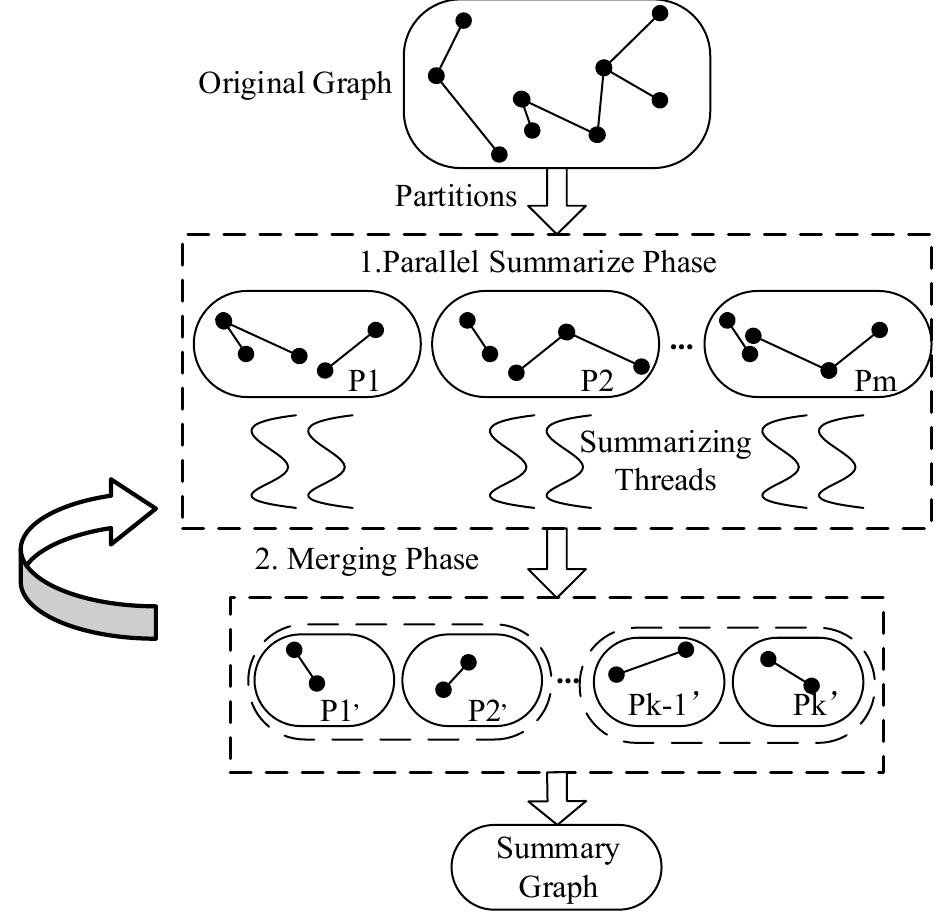
Figure 3. Hierarchical parallel graph summarization abstraction.